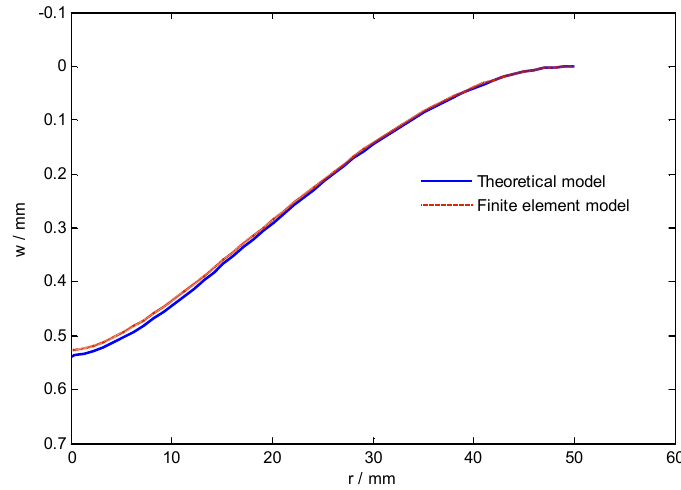
Figure 11. Deflection of the circular thin plate vs. r.